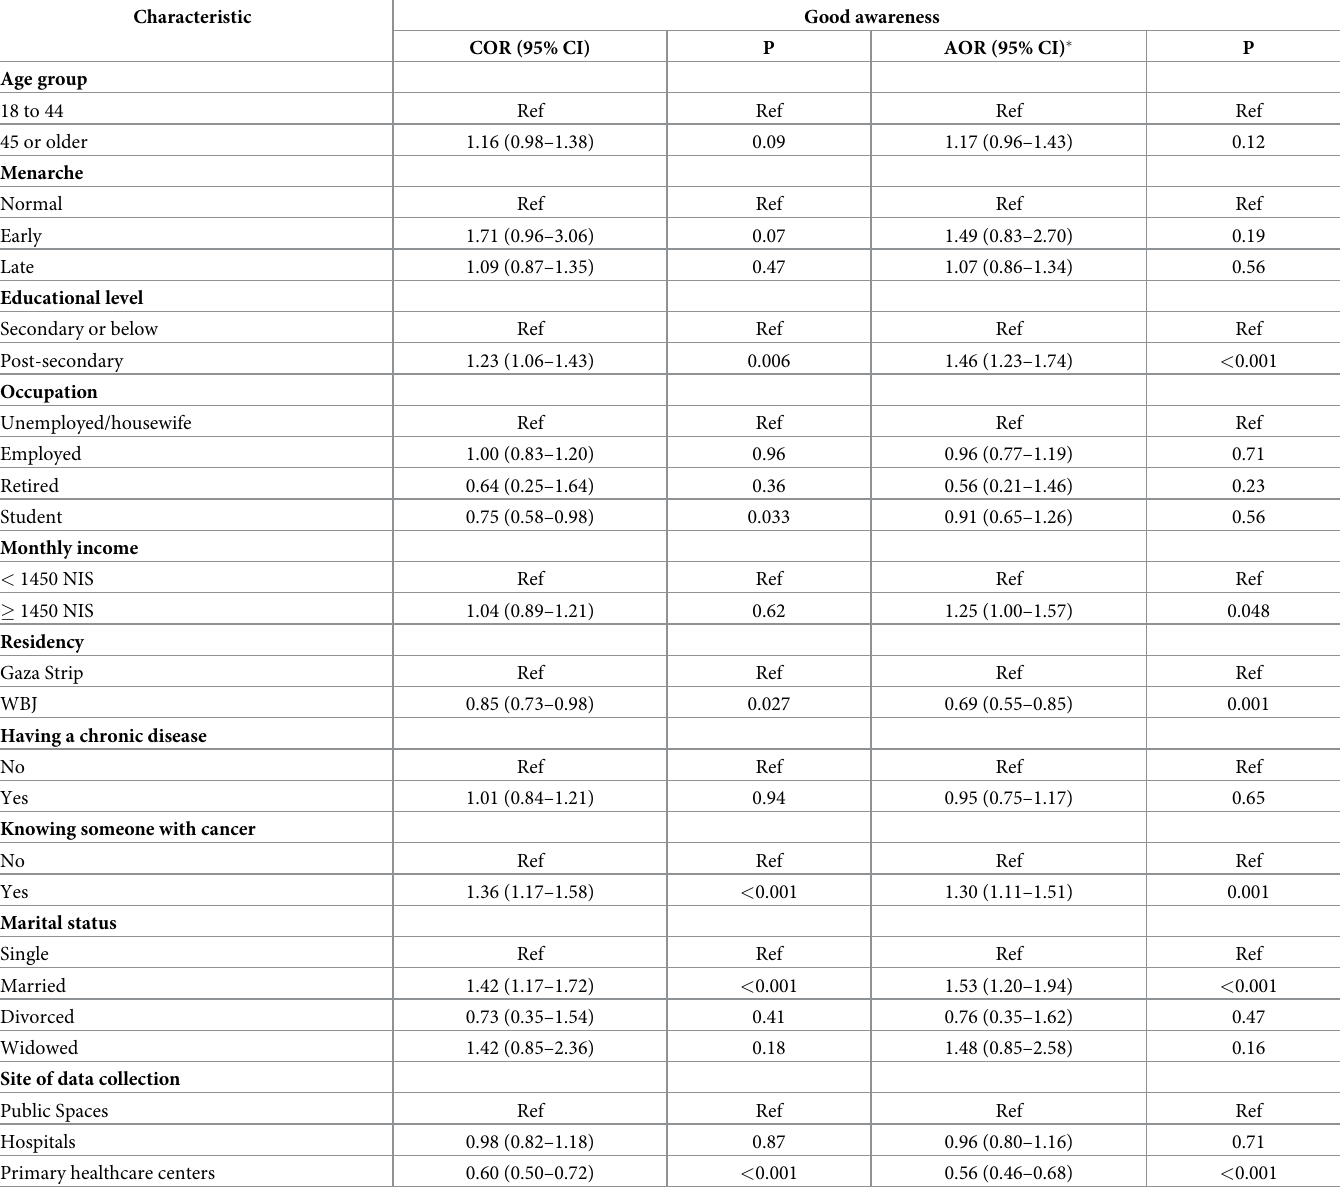
Table 4. Association of participant characteristics with having a good awareness of ovarian cancer risk and protective factors.